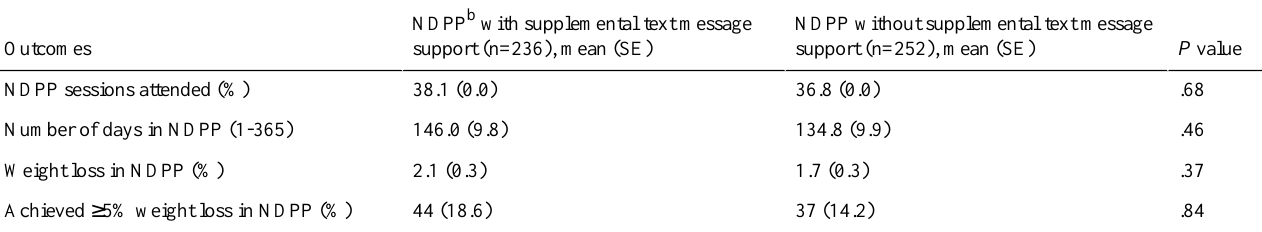
Table 1. National Diabetes Prevention Program outcomes with and without supplemental text message support, N=488 a .